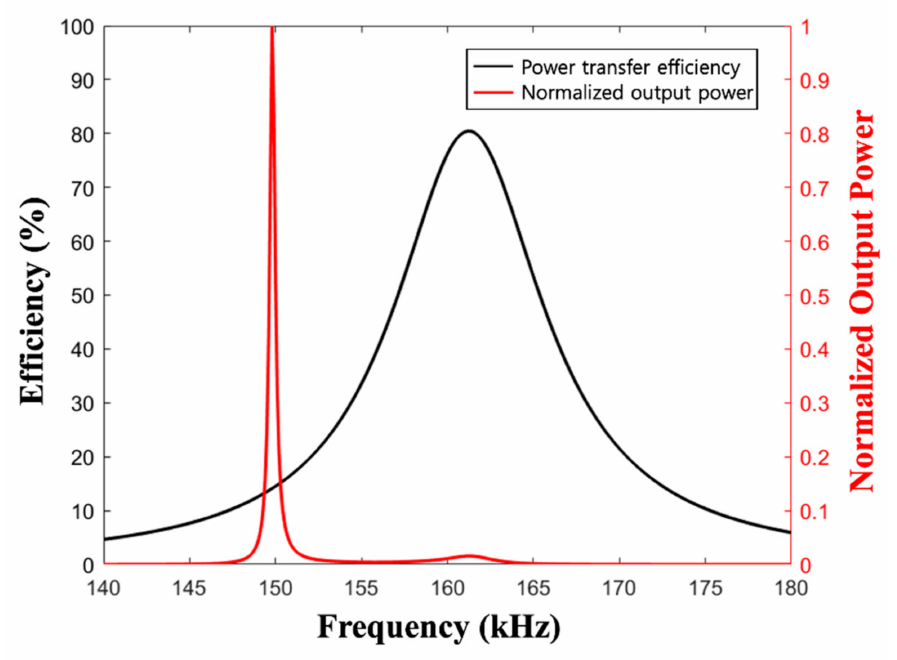
Figure 6. Calculated efficiency and normalized output power (w.r.t. its maximum value) as a function of frequency when C p is optimized to a 100 Ω